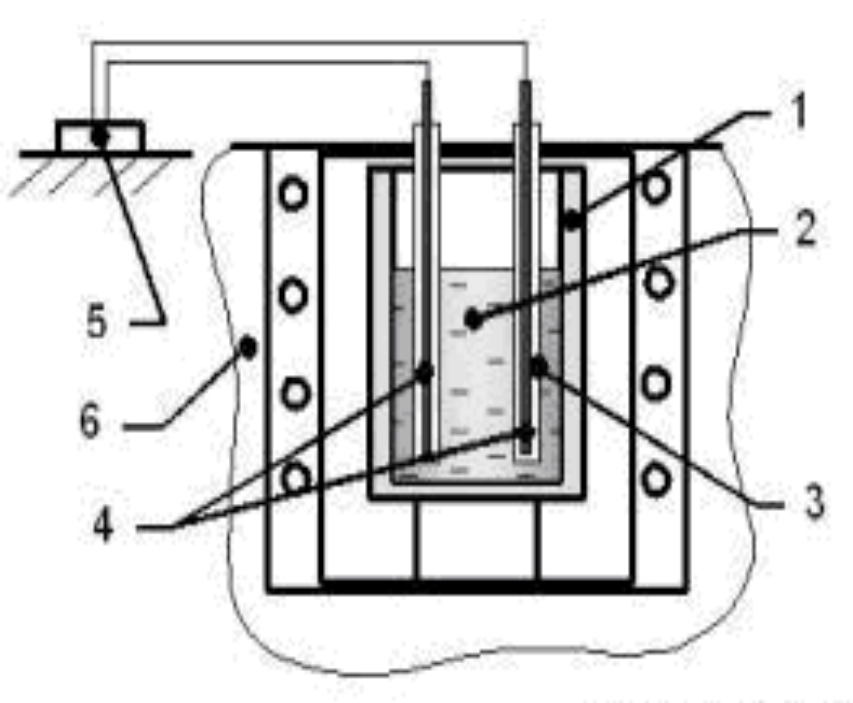
Figure 6. Scheme of treatment of the metal melt with EMP: 1—crucible, 2—melt, 3—alundum tip, 4—electrodes, 5—EMP generator, 6—“Paraboloid-4” installation [11].